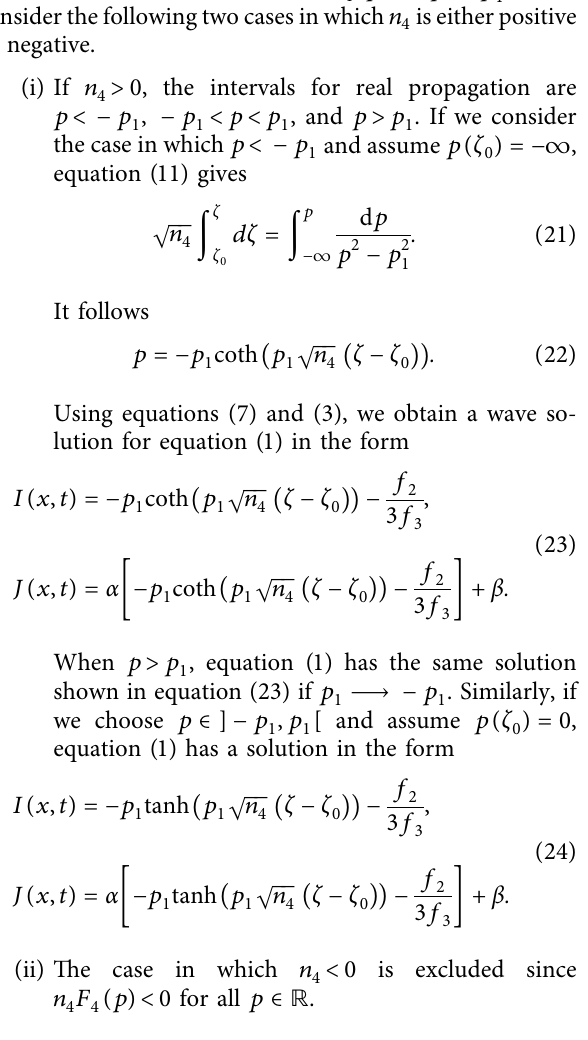
Table 1: Types of the roots of the polynomial F